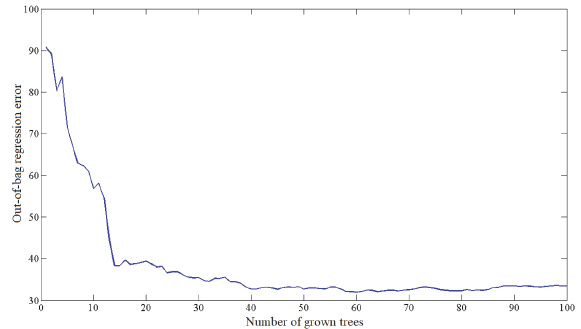
Figure 9: Relationship between number of grown trees and out-of- bag regression error.